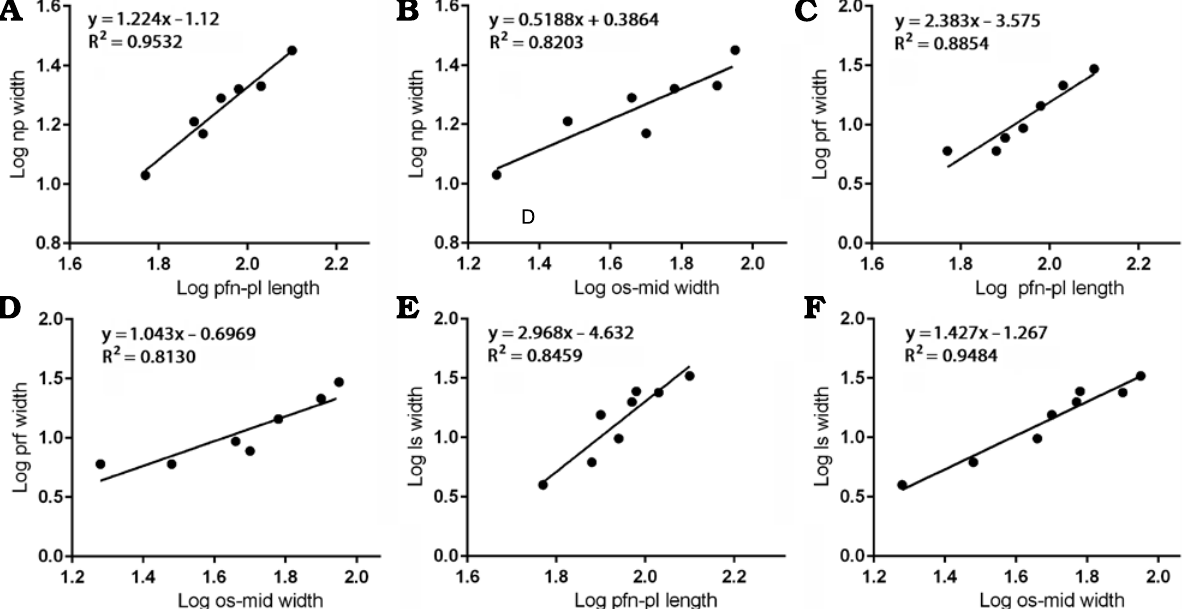
Fig. 3. Bivariate allometric results of different parts of Tarbosaurus bataar frontals. A . Width of the frontal between medial edge of the orbital slot and the midline (os-mid width, 5) and the depth of the frontal at the region that is immediately anterior to the most anterior point of the sagittal crest (depth, 9). B . Length of the frontal between prefrontonasal process and the frontoparietal suture (pfn-pl length, 4) and the depth of the frontal at the region that is immediately anterior to the most anterior point of the sagittal crest (9). C . Width of the frontal between medial edge of the orbital slot and the midline (5) and the length of the frontal between prefrontonasal process and the frontoparietal suture (4). D . Length of the frontal between prefrontonasal process and the frontoparietal suture (4) and the width of the frontal between the most lateral point of the posterior shelf and the midline (cds-mid width, 6). E . Length of the frontal between prefrontonasal process and the frontoparietal suture (4) and the brain length (8). F . Length of the frontal between prefrontonasal process and the frontoparietal suture (4) and the width of the frontal between medial edge of the orbital slot and the midline (5). G . Length of the frontal between prefrontonasal process and the frontoparietal suture (4) and the width of the frontal between the most lateral point of the posterior shelf and the midline (6). H . Width of the frontal between the most lateral point of the posterior shelf and the midline (6) and the width of the frontal between medial edge of the orbital slot and the midline (5).